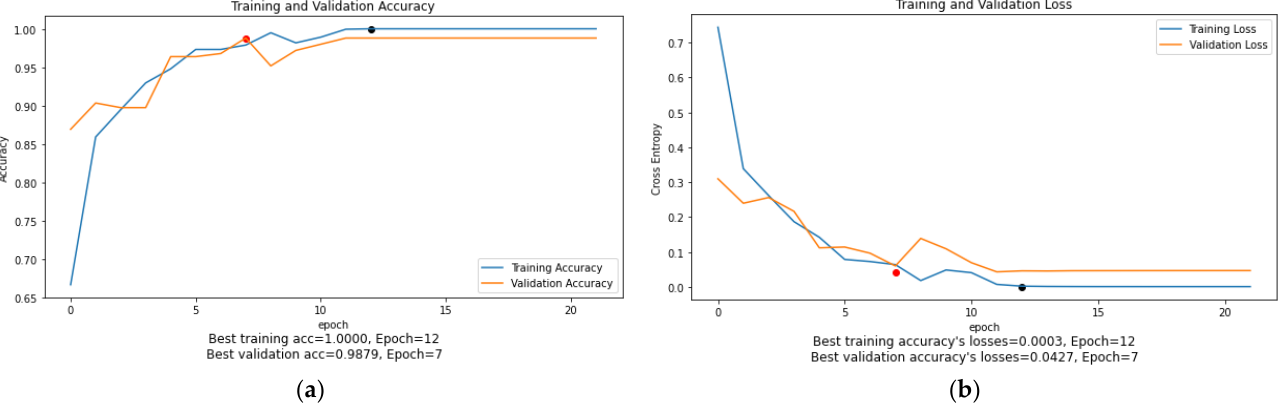
Figure 12. ( a ) Accuracy and ( b ) loss plots throughout the training process of the ResNet50 model using the GRAY+GRAY_HE+GRAY_CLAHE image representation.